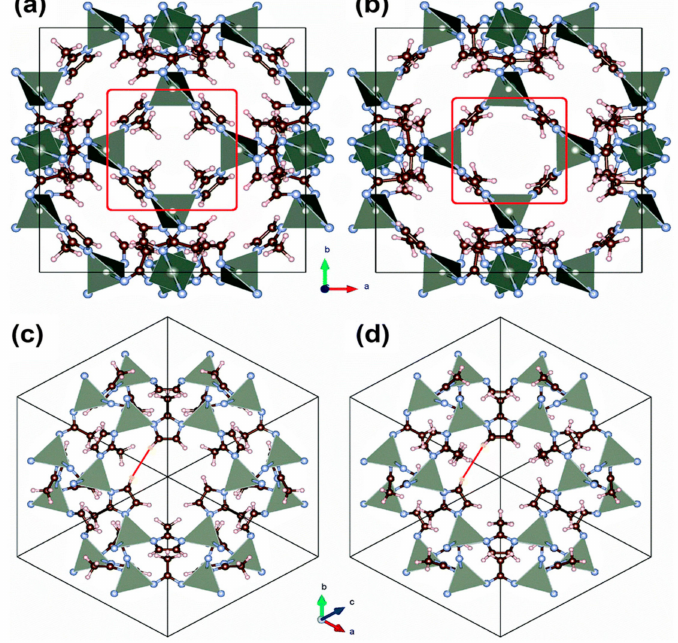
Figure 8. Linker reorientation can be observed on the linker of ZIF-8 viewing from the axis direction ( a ), and the diagonal direction ( c ), the corresponding structure of ZIF-8 loaded with N 2 , ( b , d ) [90]. The distinctive characteristic between linker rotation / gate opening behavior and breathing phenomena is that the rotational movement by the linker results in the expansion of the pore windows while a change in the unit cell of the crystal occurs during